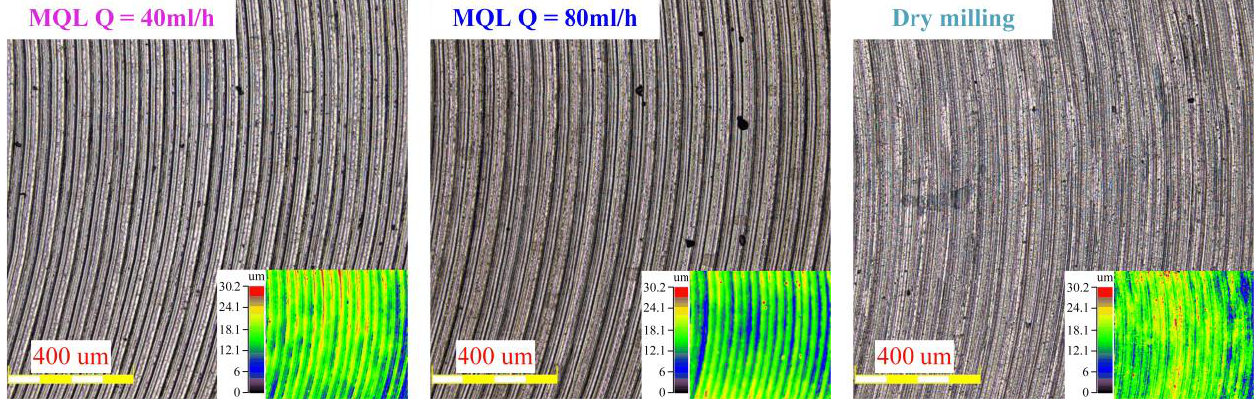
Figure 13. The surface topography of the machined workpiece at different lubrication amounts.